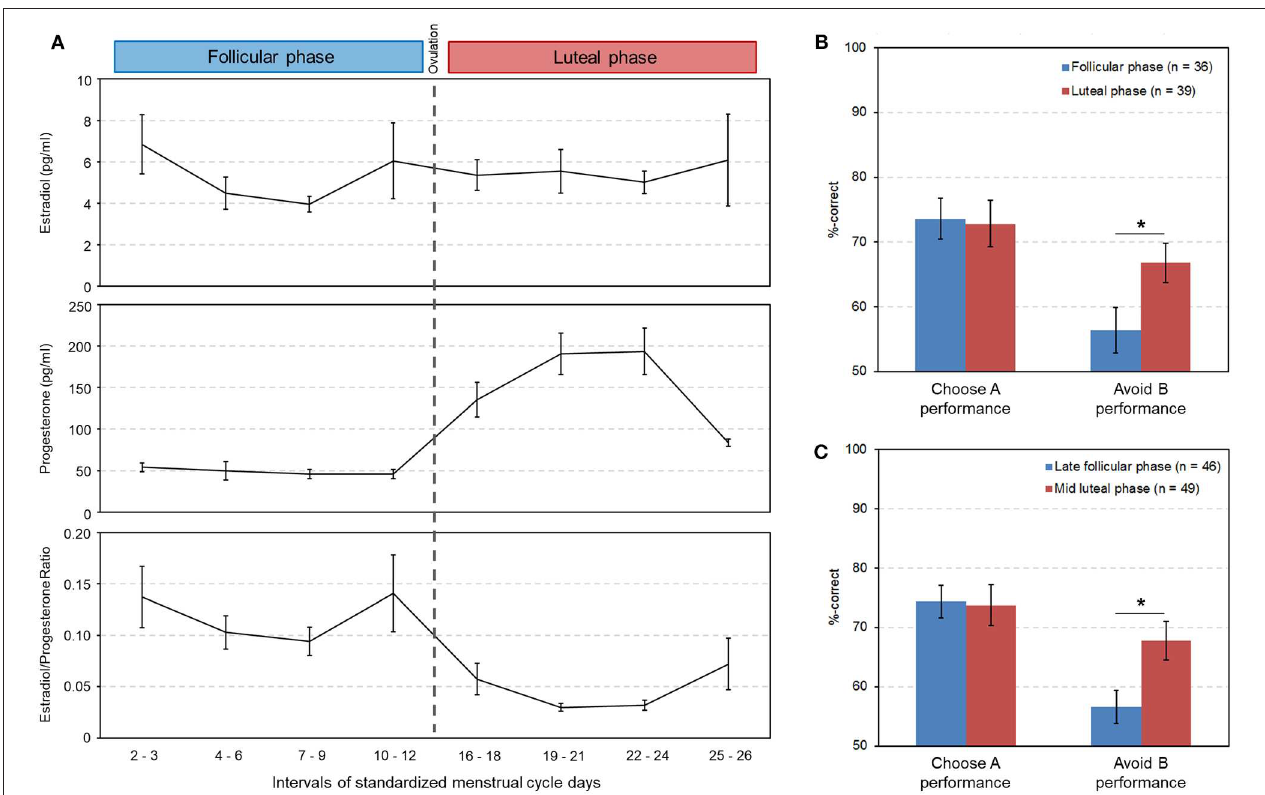
FIGURE 2 | Hormonal changes across the menstrual cycle and their association with reinforcement learning. (A) Changes in salivary estradiol, progesterone and in the estradiol/progesterone ratio across the menstrual cycle (data are from independent subjects; cycle days were standardized to a 28-day cycle). Days 13–15, during which ovulation most likely occurred, are not shown here. (B) Significantly lower punishment sensitivity in the follicular phase as opposed to the luteal phase in the between-subjects study [ t (73) = − 2.27, p = 0.026, Cohen’s d = 0.52, 95% CI [lower, upper] = − 19.60, − 1.27]. (C) Significantly lower punishment sensitivity in the late follicular phase compared to the mid luteal phase in the meta-analysis [ t (86) = − 2.62, p = 0.01, Cohen’s d = 0.56, 95% CI [lower, upper] = − 19.60, − 2.70]. Significant differences between cycle phases ( p < 0.05) are indicated with an asterisk.